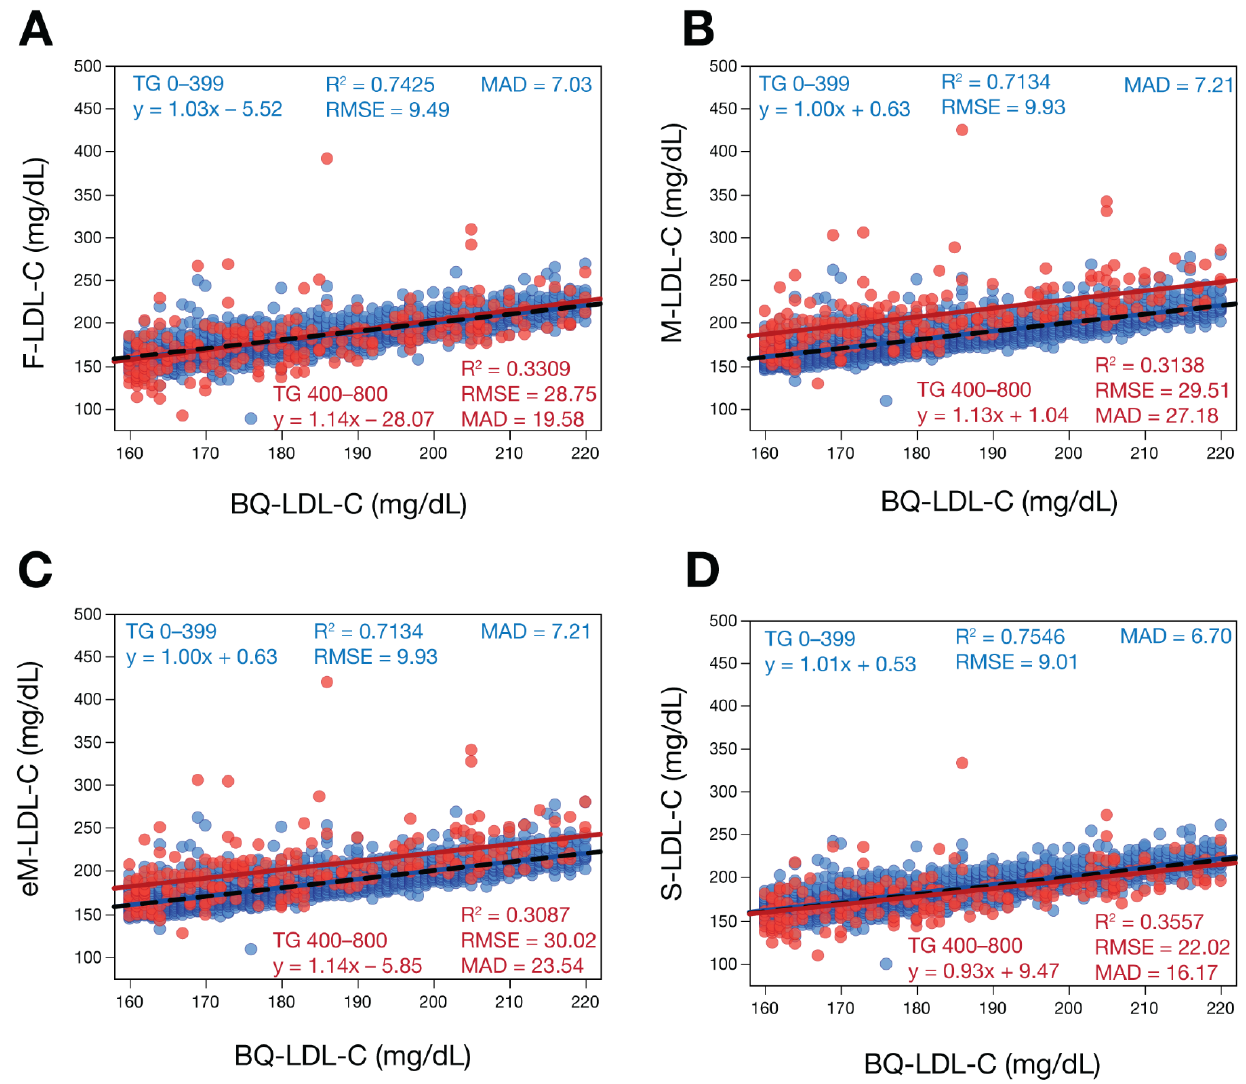
Figure 5. Comparison of estimated LDL-C versus BQ-LDL-C for samples with high LDL-C. LDL-C was calculated for patients (N = 5060) with LDL-C between 160 and 220 mg/dL by F-LDL-C (Panel A ), M-LDL-C (Panel B ), eM-LDL-C (Panel C ) and S-LDL-C (Panel D ) equations and plotted against LDL-C as measured by BQ reference method (BQ-LDL-C). Solid red lines are the linear fits for the indicated regression equations for samples with TG > 400 mg/dL. Dotted lines are lines of identity. Results are color coded by TG level with TG < 400 mg/dL indicated in blue and TG 400–800 mg/dL in